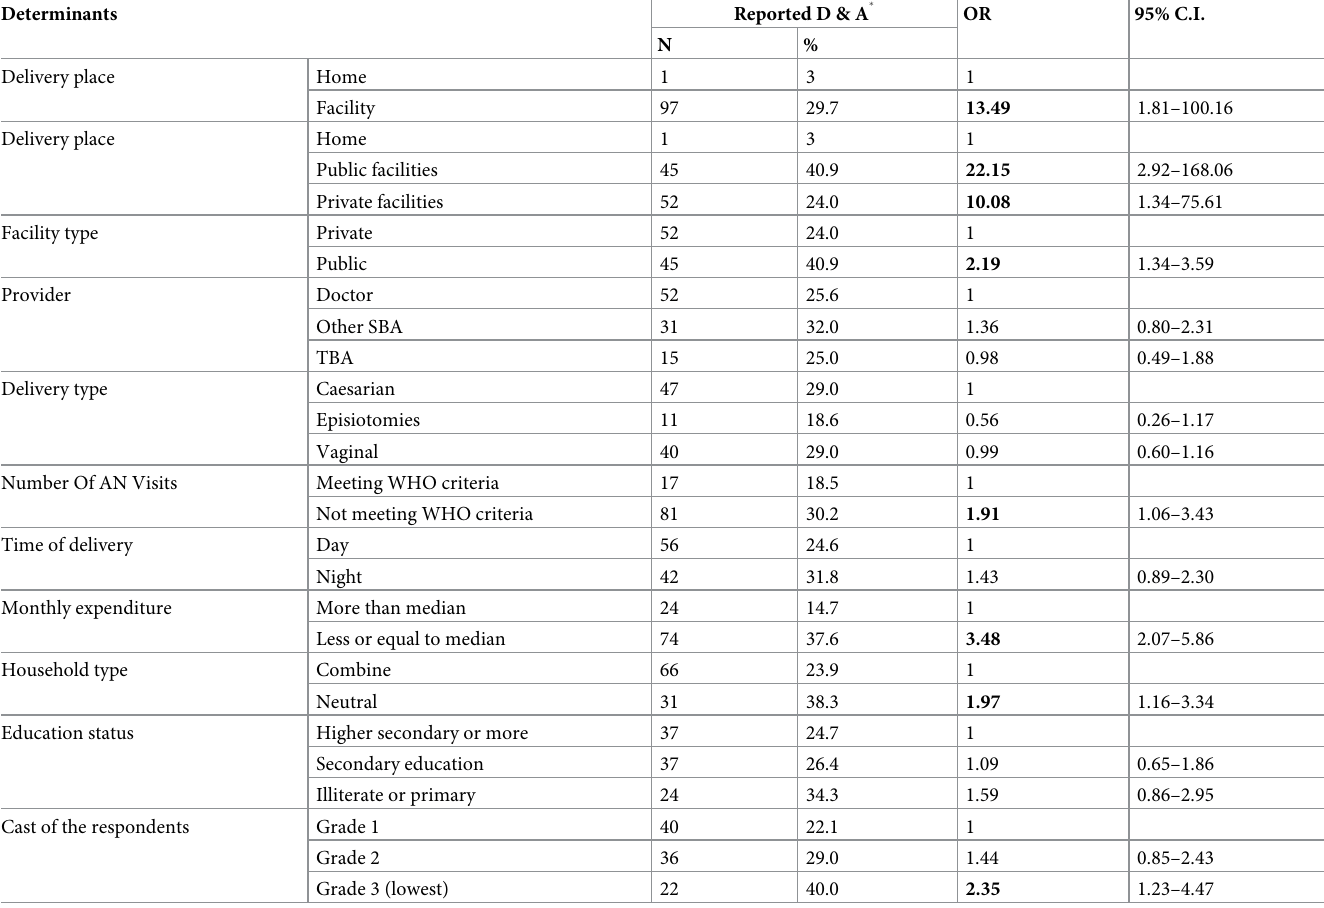
Table 5. Determinants of reported D & A- results from univariate